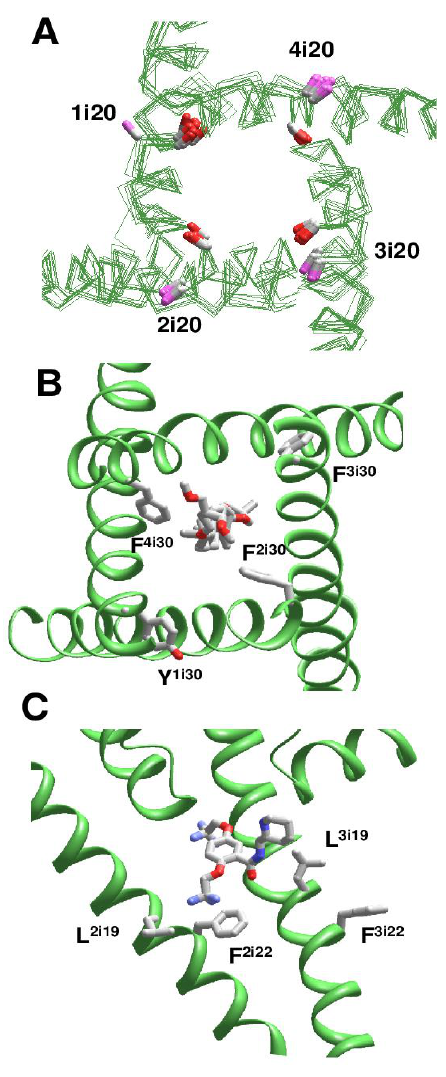
Figure 5. π -Bulges affect patterns of ligand-sensing residues in eukaryotic Nav channels. A , N i20 _C α -C β bonds in reg- ular alpha- helices and π -bulged helices are shown with magenta and red CB atoms, respectively. B , A steroidal molecule